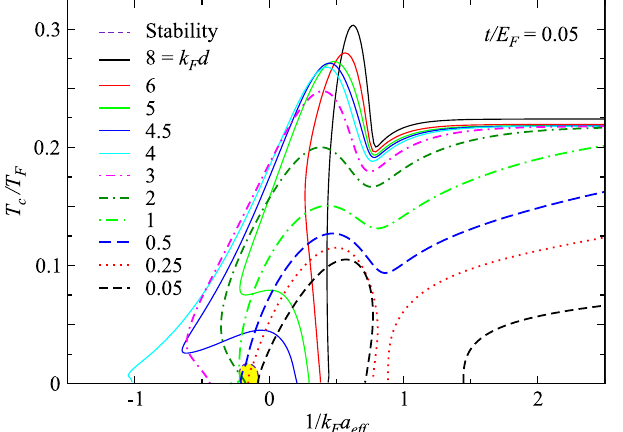
Figure 3. Behavior of T c as functions of k a 1/ at fixed t / E F = 0.05, but for different value of k F d from 8 to 0.05. F eff The T c solution in shaded regions is unstable against phase separation.